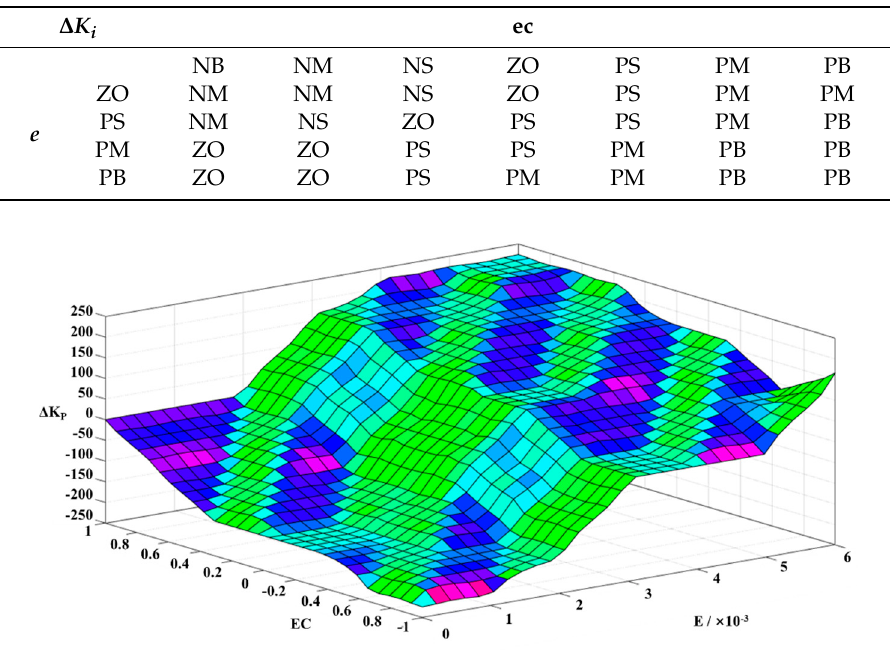
Table 5. Fuzzy rules for integral gain ∆ K i in the fuzzy control algorithm.